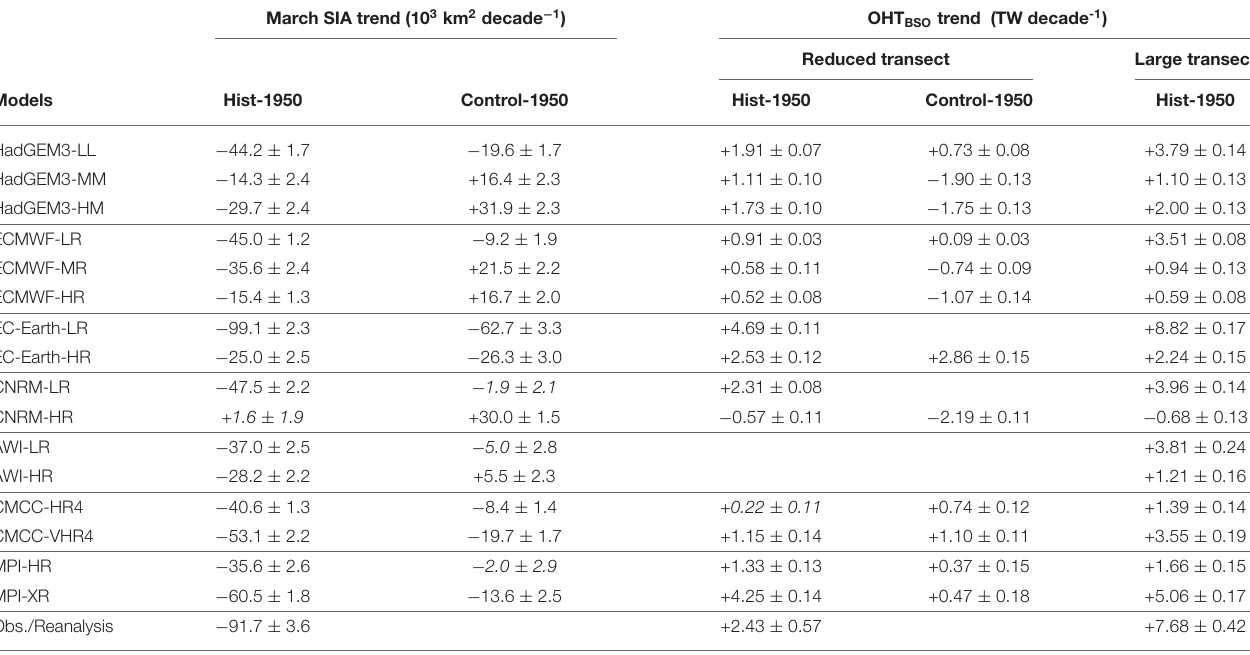
TABLE 2 | Trends in March sea-ice area (SIA) in the Barents Sea and ocean heat transport (OHT) at the Barents Sea Opening (BSO; both reduced and large transects) for the different model configurations, computed for the record from 1950 to